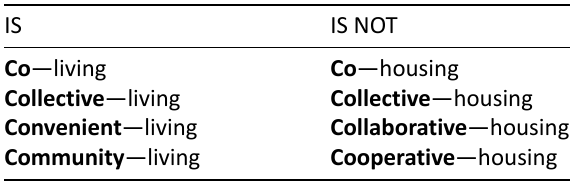
Table 1. Possible meanings of the “co‐” prefix in co‐living compared to the ones of